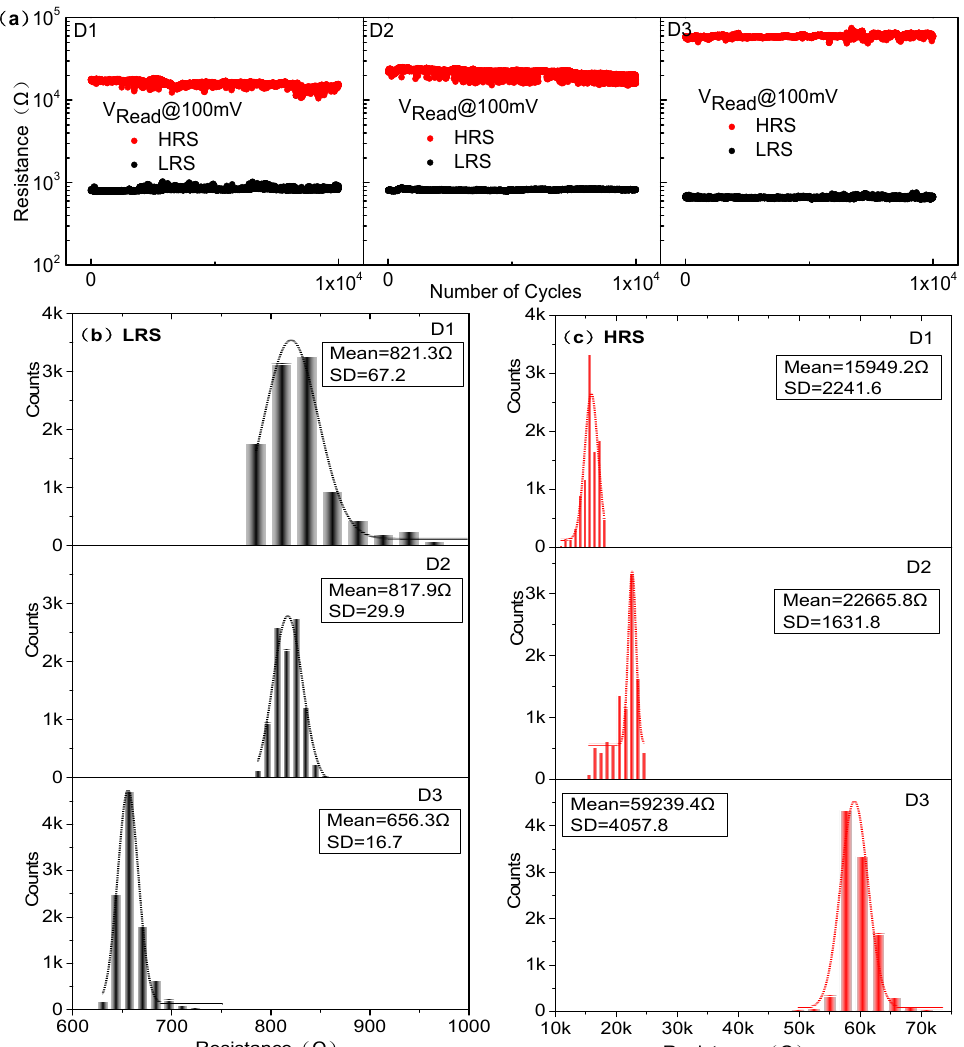
Figure 4. ( a ) Endurance of 10 4 DC cycles of the D1, D2, and D3 devices, ( b ) Probability distribution histogram of (b) LRS and ( c ) HRS for the D1, D2, and D3 devices.